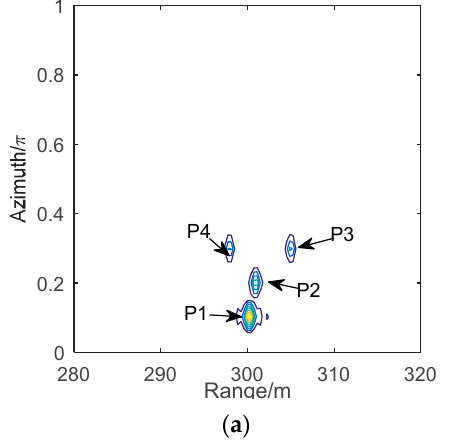
Figure 7. The 2-D imaging result of range-azimuth in the bistatic geometry. ( a ) The result of TR1; ( b ) the result of TR2.